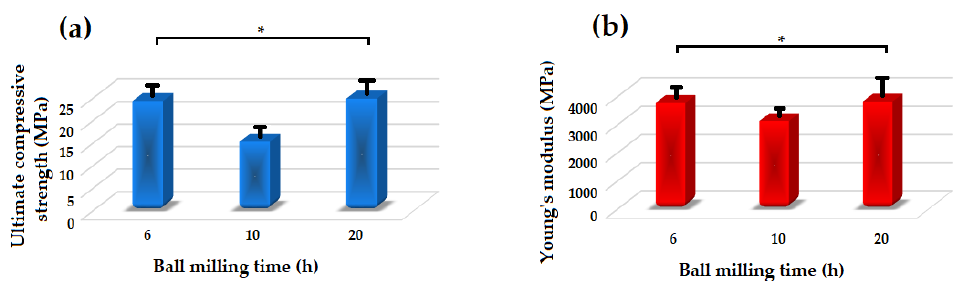
Figure 8. Mechanical properties of the akermanite tablets. (* not significantly different).